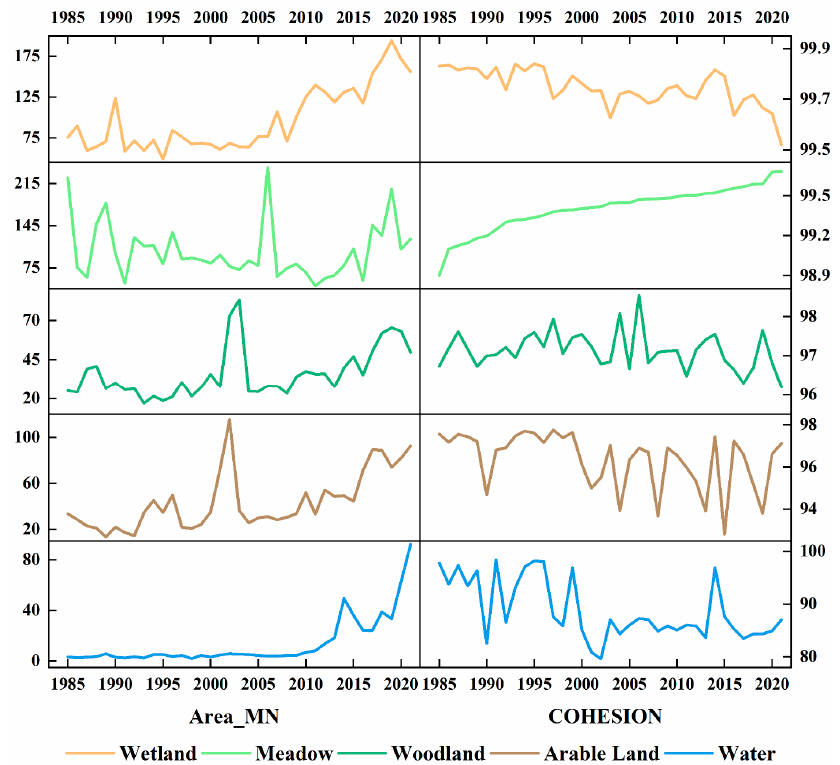
Figure 7. Changes in Area_MN and COHESION values of the landscape types in the HNNR from 1985 to 2021.